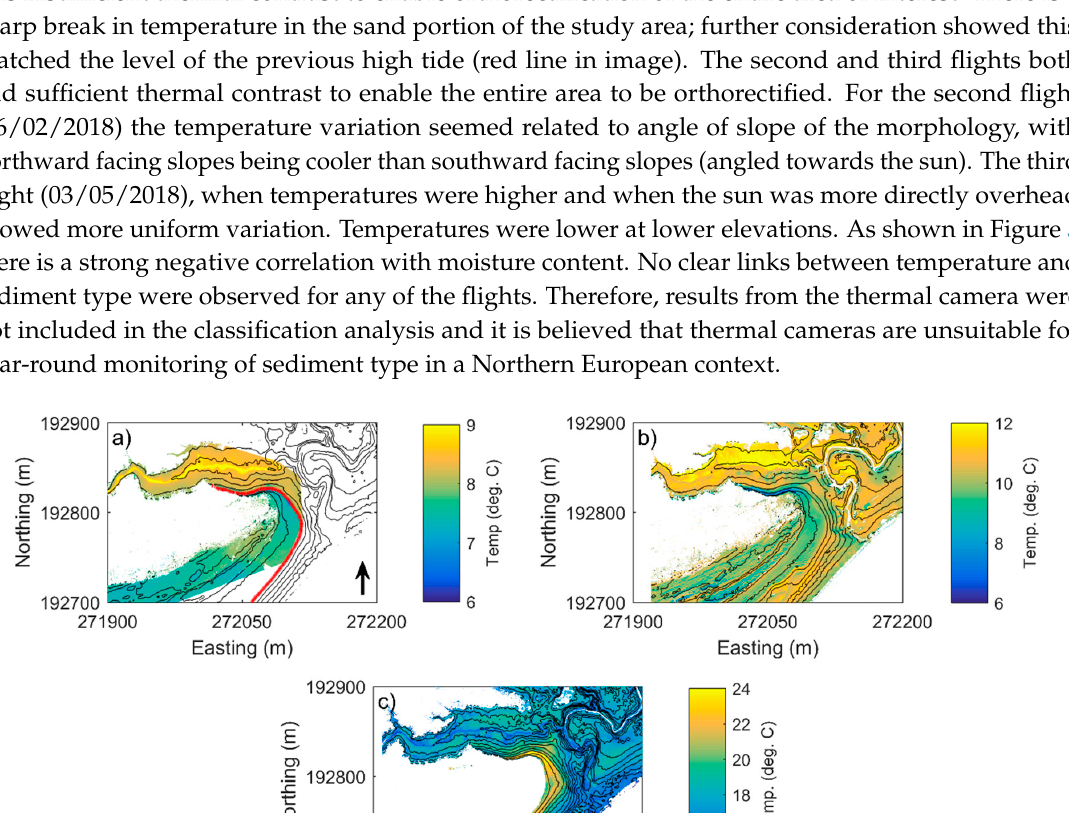
Figure 6. Plots of UAS-measured temperature for the flight on ( a ) 30/01; ( b ) 16/02; and ( c ) 03/05. A north arrow is given in panel ( a ). In figure ( a ) the red line indicates the extent of the previous high tide. To further explore temperature variation, Figure 6 shows maps of temperature for the three flights. For all panels, color shading indicates UAS-measured temperature and black contours the morphology. The upper panel shows the first flight (30/01/2018), due to low temperatures, there was insufficient thermal contrast to enable orthorectification of the entire area of interest. There is a sharp break in temperature in the sand portion of the study area; further consideration showed this. matched the level of the previous high tide (red line in image). The second and third flights both had sufficient thermal contrast to enable the entire area to be orthorectified. For the second flight (16/02/2018) the temperature variation seemed related to angle of slope of the morphology, with northward facing slopes being cooler than southward facing slopes (angled towards the sun). The third flight (03/05/2018), when temperatures were higher and when the sun was more directly overhead showed more uniform variation. Temperatures were lower at lower elevations. As shown in Figure 5 there is a strong negative correlation with moisture content. No clear links between temperature and sediment type were observed for any of the flights. Therefore, results from the thermal camera were not included in the classification analysis and it is believed that thermal cameras are unsuitable for year-round monitoring of sediment type in a Northern European context.